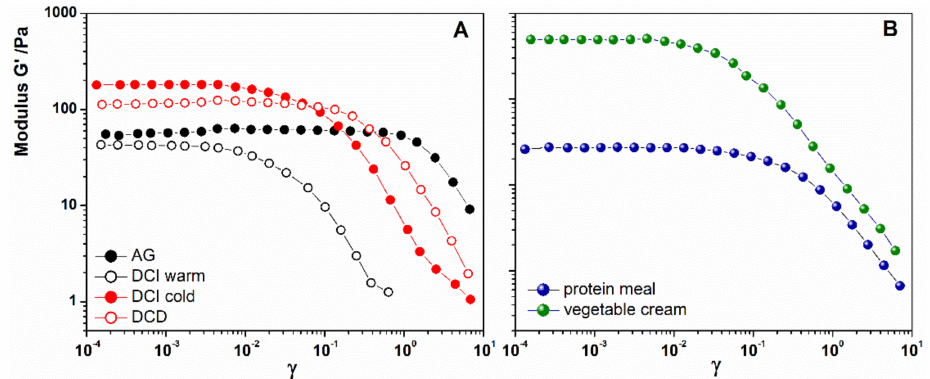
Figure 3. ( A ) Amplitude strain sweep of AG (full black circles), DCI hydrated with warm water (open black circles), DCI hydrated with cold water (full red circles), DCD (open red circles), ( B ) amplitude strain sweep of Protein Meal (full blue circles) and Vegetable Cream (full green